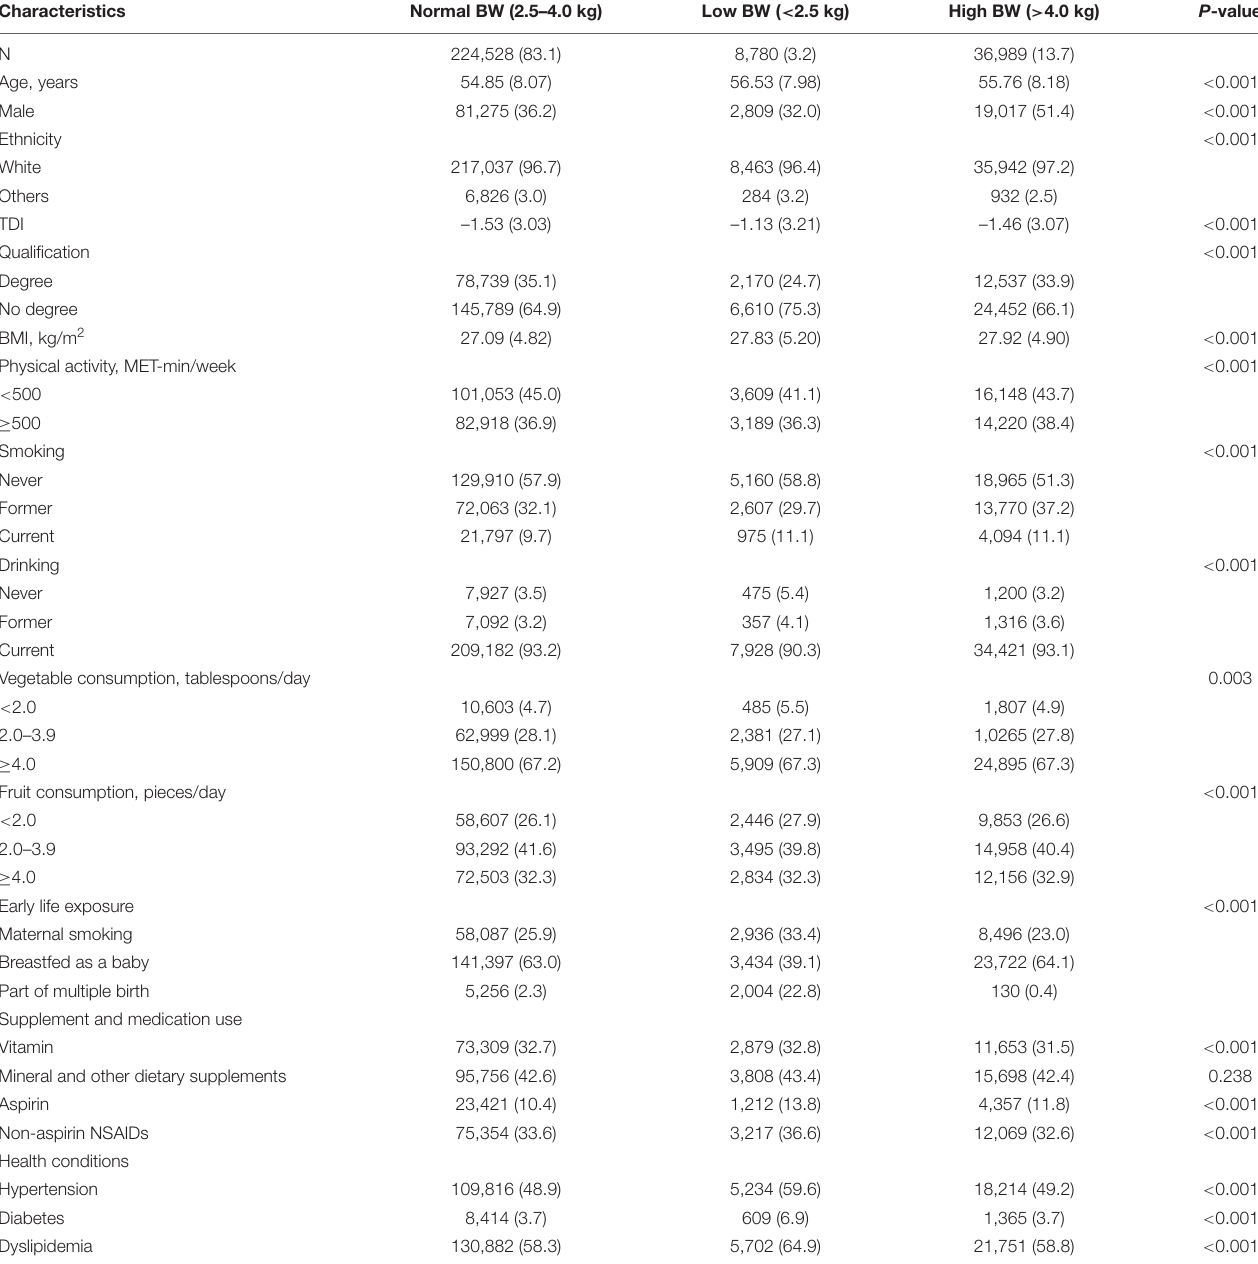
TABLE 1 | Baseline characteristics of study